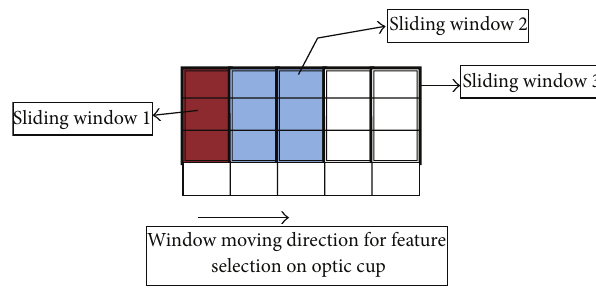
Figure 1: Sliding window on DFIR method.